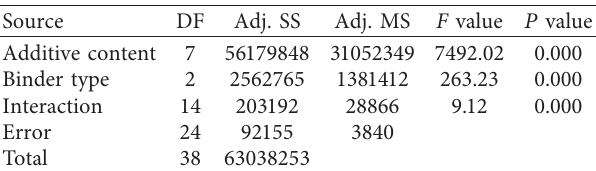
Table 15: Two-way ANOVA: fatigue life versus additive and binder type. DF